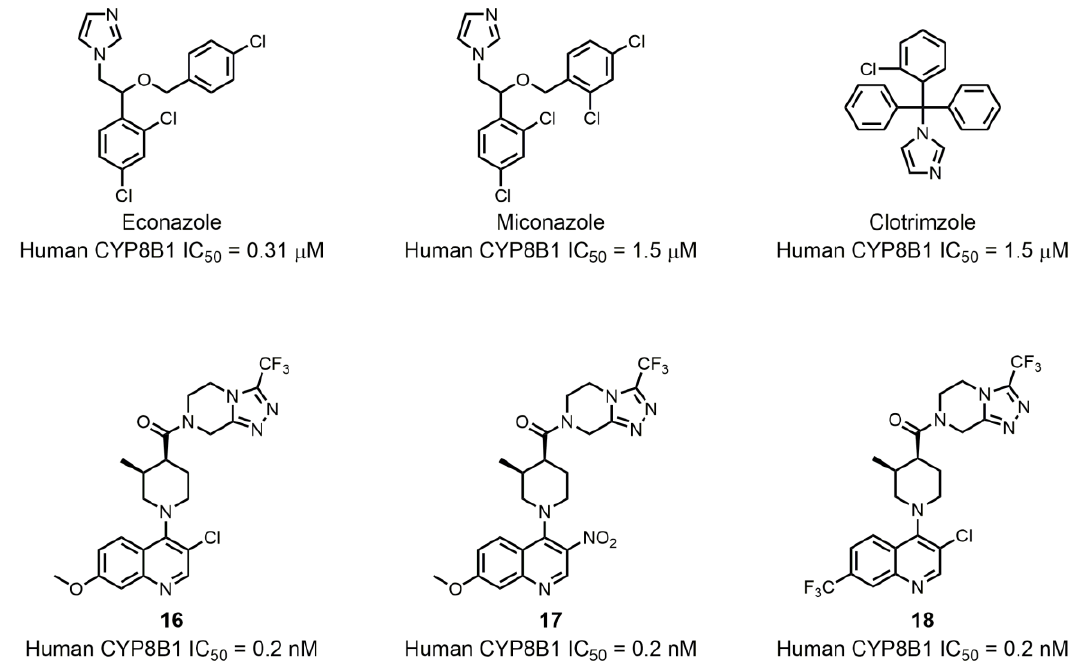
FIGURE 9: CYP8B1